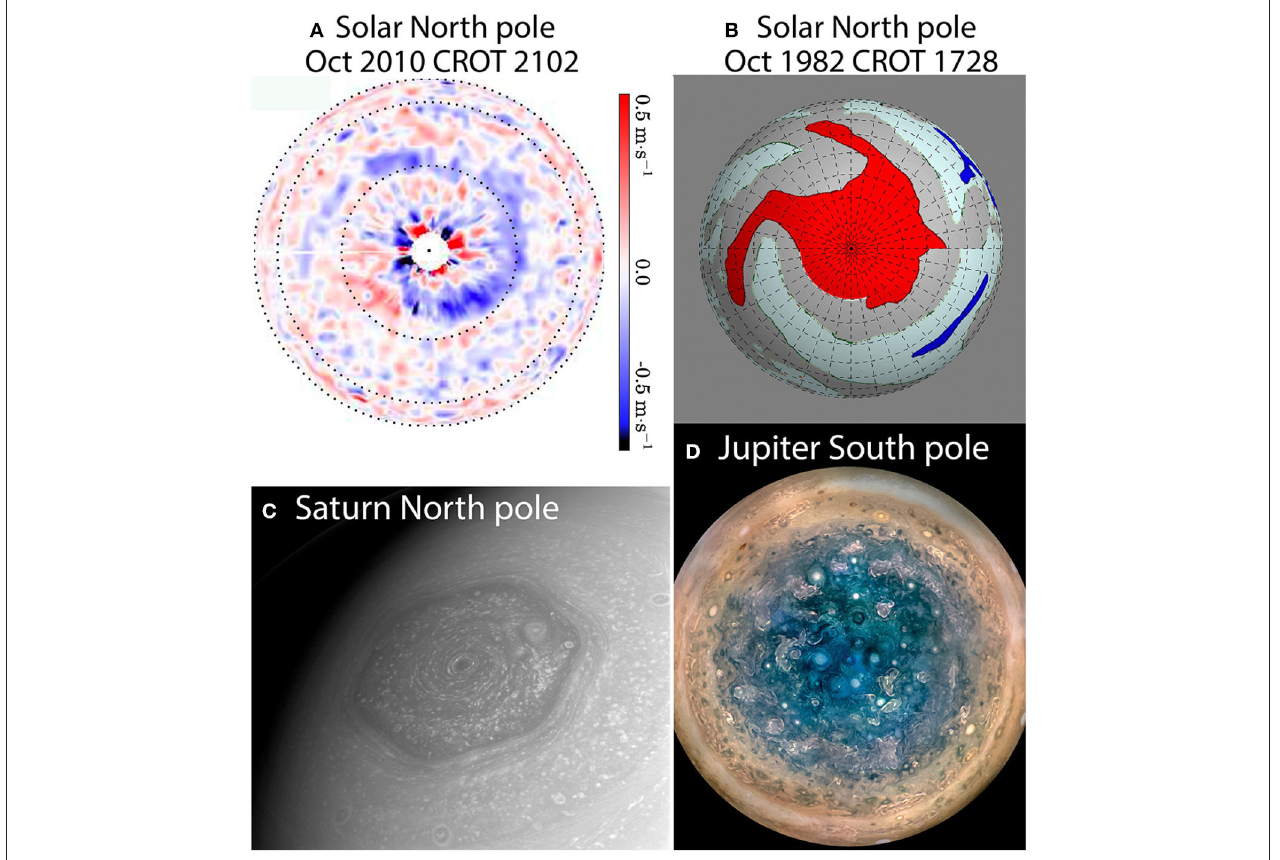
FIGURE 7 | (A) Ring-diagram analysis of near-surface flow anomalies indicate spiral flow patterns at the poles (from Bogart et al., 2015; Copyright ©AAS. Reproduced with permission). (B) Observations of large-scale, high-latitude magnetic features spanning multiple decades ( McIntosh et al., 1976; McIntosh, 2003) similarly demonstrate spiral structure at the poles (from Webb et al., 2018) (red = negative coronal hole, blue = positive coronal hole, gray = negative polarity quiet Sun, light blue = positive polarity quiet Sun, dark green = filaments). (C) A view centered on Saturn’s north pole. North is up and rotated 33 ◦ to the left. The image was taken with the Cassini spacecraft wide-angle camera on June 14, 2013 using a spectral filter sensitive to wavelengths of near-infrared light centered at 752 nm (Source: NASA JPL). (D) Multiple images combined show Jupiter’s south pole, as seen by NASA’s Juno spacecraft from an altitude of 32,000 miles. The oval features are cyclones. (Credit: NASA/JPL - Caltech/SwRI/MSSS/Betsy Asher Hall/Gervasio